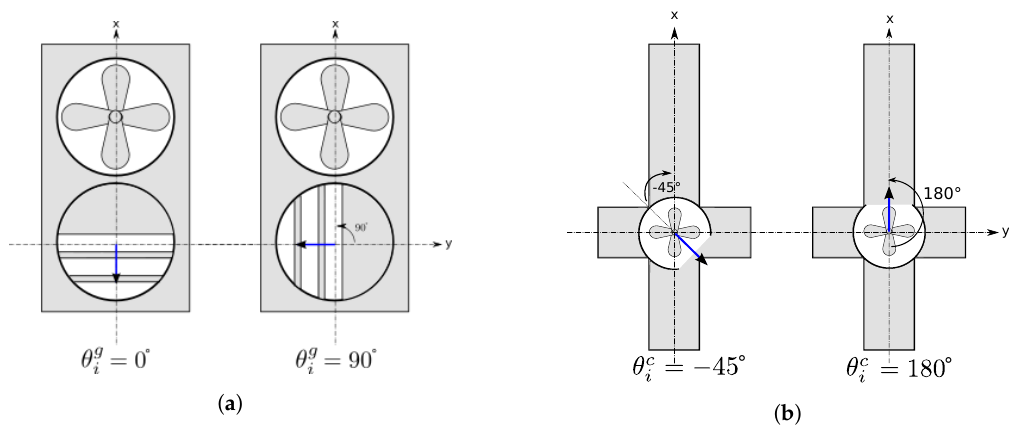
Figure 2. An abstract bottom section of the nested 360-degrees-steerable actuators, where the x-axis points to the bow, the y-axis starboard, and the z-axis downwards. The blue arrows denote the theoretical orientation of the water exiting the systems: ( a ) steering-grid thruster placed at the bow, and ( b ) four-channel thruster positioned at the stern, adapted from [39] with permission from MDPI, 2020.